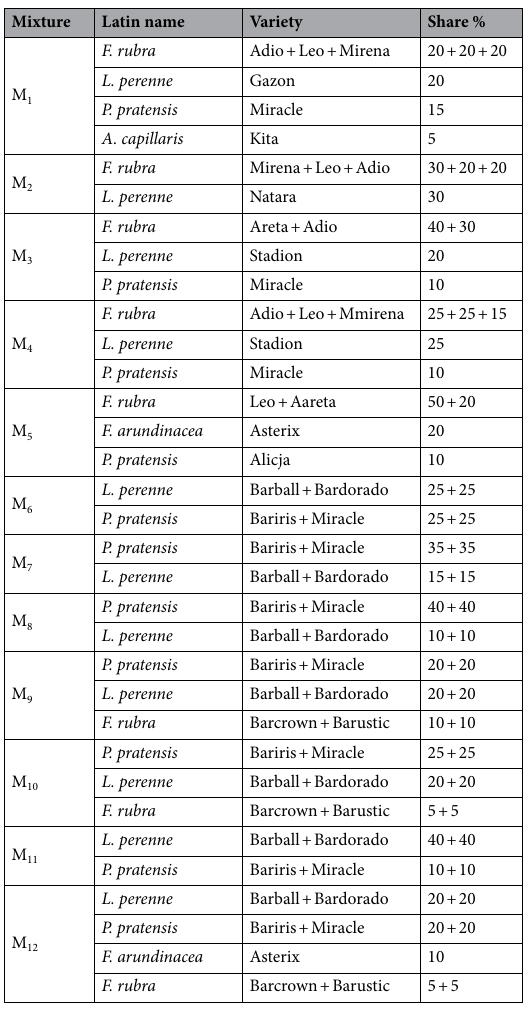
Table 2. Species composition of lawn grass mixtures.